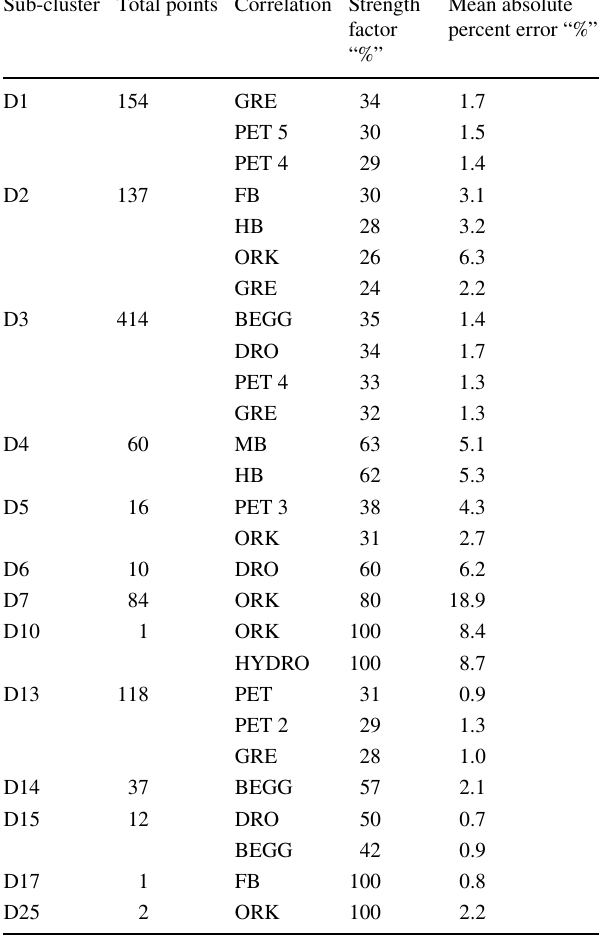
Table 11 Best correlations for cluster (C) Sub-cluster Total points Correlation Strength